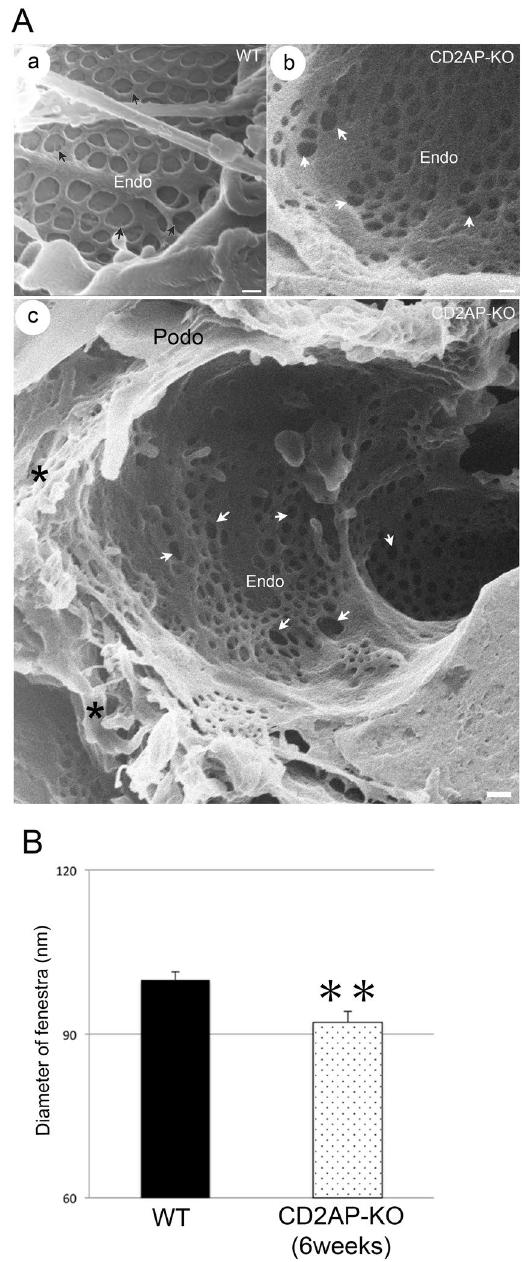
Figure 7. Endothelium and interface of podocyte and endothelium in WT and CD2AP deficient mice. ( A ) HIM images of glomerular filtration slits in WT (a) and 6 week-old Cd2ap -KO (b, c) mice. (a) The WT image shows the smooth endothelial surface and endothelial fenestrae with membranous structure underneath. Some of these fenestrae contain faint spokes that appear like bicycle wheels (black arrows). (b) The image of 6 week- old Cd2ap -KO endothelium shows smaller fenestrae, many of which lost underlying membrane structure, revealing many open “holes” underneath (white arrows). Scale bars, 100 nm. (c) HIM image of the interface between podocytes and endothelium in 6 week-old Cd2ap -KO mice. Cd2ap -KO mice lost interdigitated foot processes. There are multiple layers of overlaid “flat sheets” that loosely attached to the underlying GBM and endothelium (asterisk). The inner endothelial surface contains numerous fenestrae, most of which lack underlying supporting structures (white arrows). Scale bars, 100 nm (a, b); 200 nm (c). Podo, podocyte; Endo, endocapillary space. ( B ) The diameter of randomly selected endothelial fenestrae is quantified by ImageJ software in WT (n = 46) and 6 week-old Cd2ap -KO (n = 78) from HIM images. All values are presented as means ± standard error of the mean, SEM. ** p <